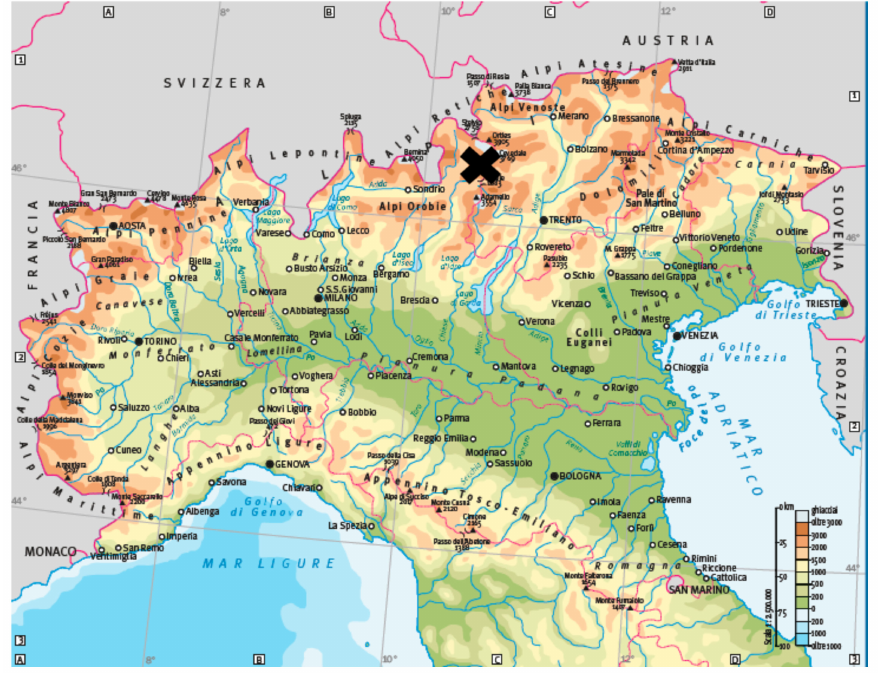
Figure 1. Position of Valfurva with respect to